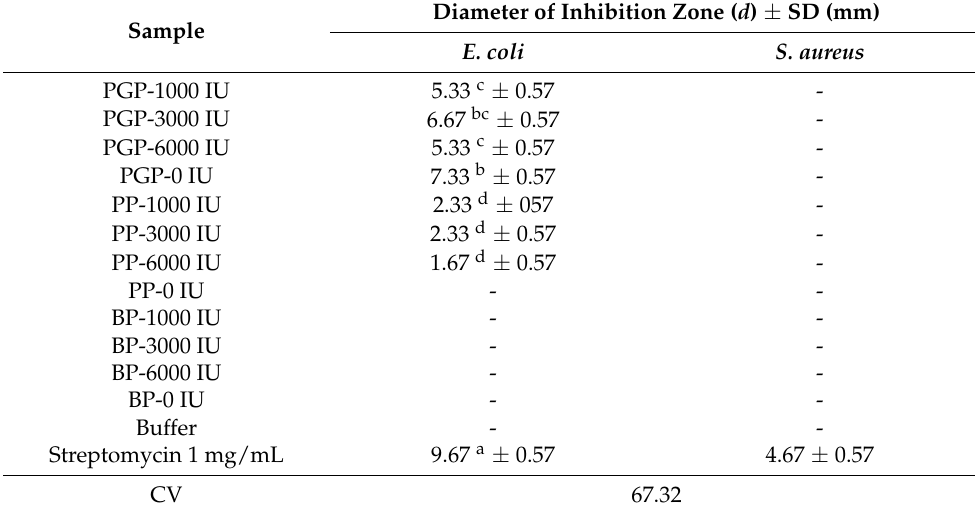
Table 4. Inhibition zone of three fermented fruit peel extracts.